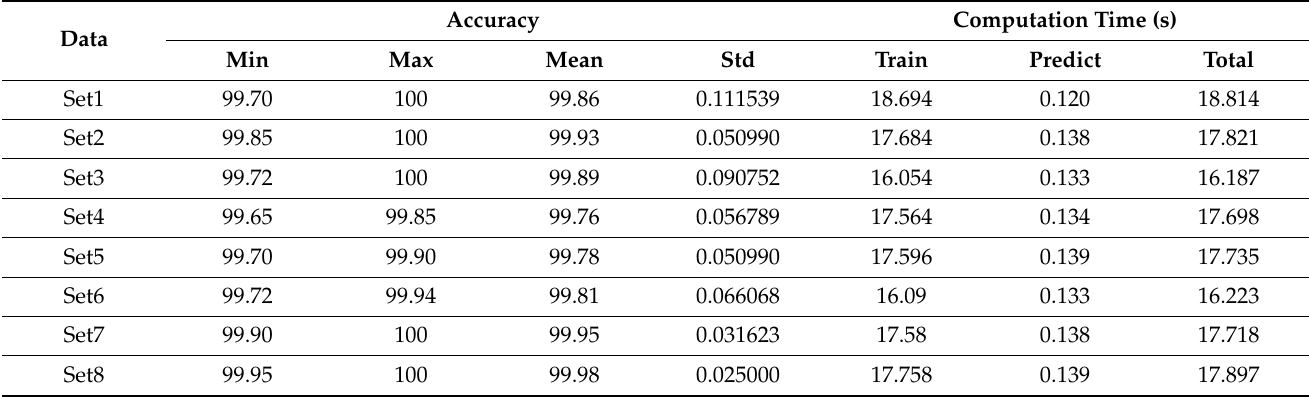
Table 9. Bearing fault diagnosis accuracy performance and computation time of the proposed lite CNN model for all datasets